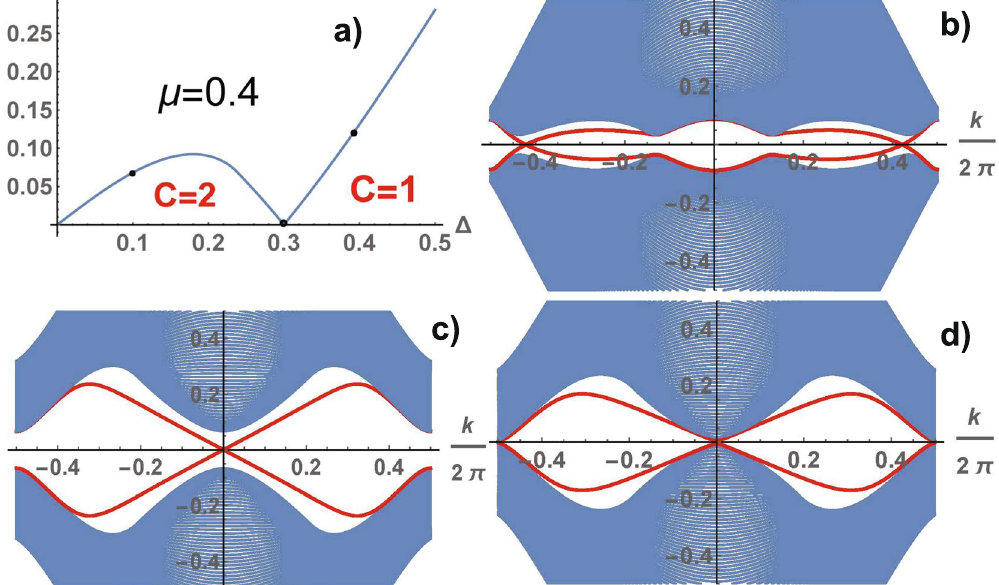
Figure 7. Evolution of the spectrum of TSC calculated for system with zig-zag boundary along the profile of the gap at μ = 0.4 in the points marked in Fig. 6b ( a ) for Δ = 0.1 (the state with C = 2) ( b ), Δ = 0.3 (the point of the topological phase transition) ( d ), Δ = 0.4 (the state with C = 1) ( c ). The number of pairs of edge modes is equal to the total Chern number of the bands below the gap, the wave vector directed along the zig-zag